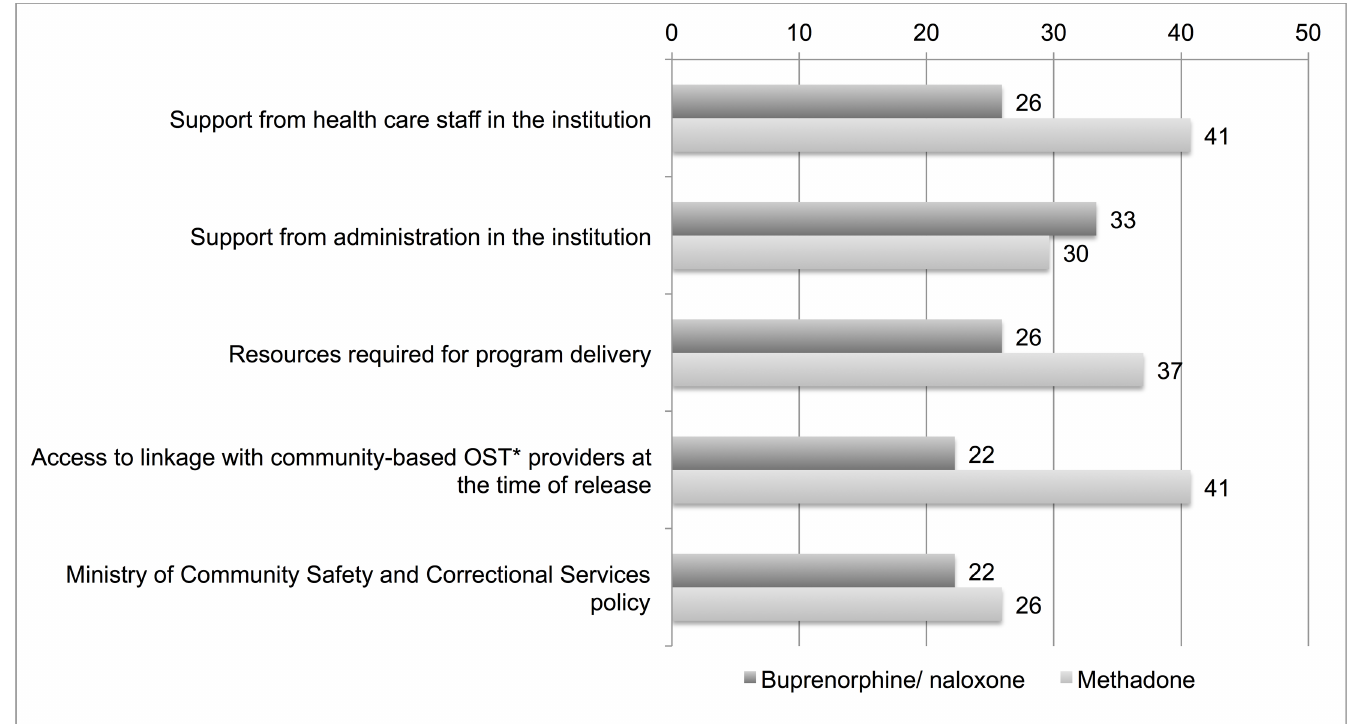
Fig 2. Facilitators of initiating opioid agonist treatments reported by physicians working in provincial correctional facilities for adults in Ontario, Canada, % of N = 27. (cid:3) OST = opioid substitution therapy, which includes opioid agonist treatments methadone and buprenorphine/naloxone.